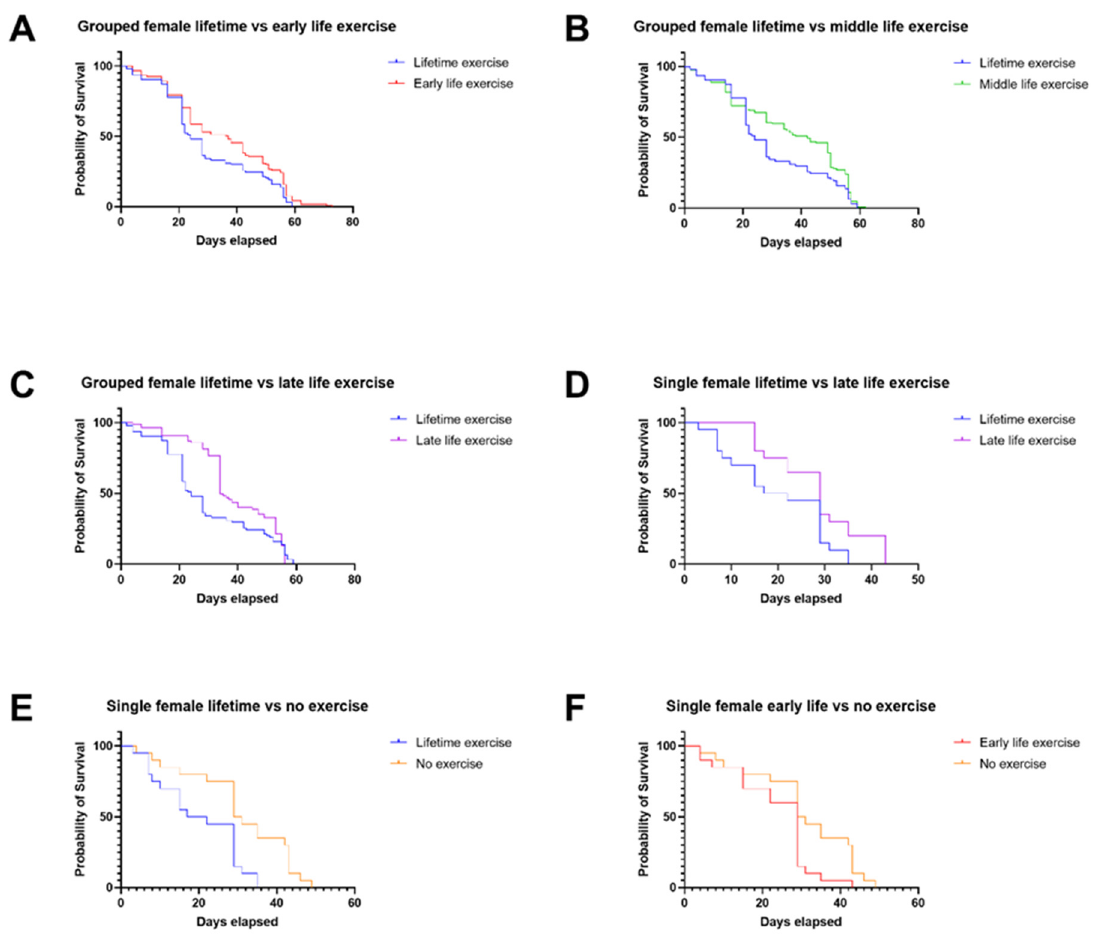
Figure 2. Percentage probability of survival for grouped and single female flies: ( A ) Grouped female lifetime vs. early-life exercise ( n = 94, 121, respectively) (log-rank test p = 0.0094). ( B ) Grouped female lifetime vs. middle-life exercise ( n = 94, 127, respectively) (log-rank test p = 0.0141). ( C ) Grouped female lifetime vs. late-life exercise ( n = 94, 85, respectively) (log-rank test p = 0.0241). ( D ) Single female lifetime vs. late-life exercise ( n = 20, 20, respectively) (log-rank test p = 0.0202). ( E ) Single female lifetime vs. no exercise ( n = 20, 20, respectively) (log-rank test p = 0.0025). ( F ) Single female early-life vs. no exercise ( n = 20, 20, respectively) (log-rank test p = 0.0202).